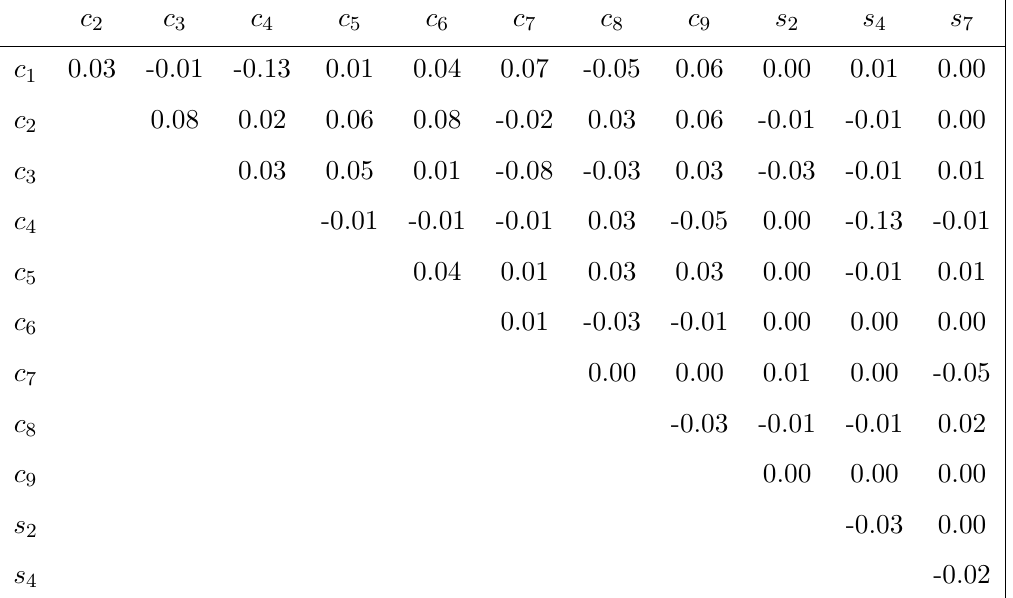
Table 10 . Statistical correlation coe(cid:14)cients between c i and s i values.